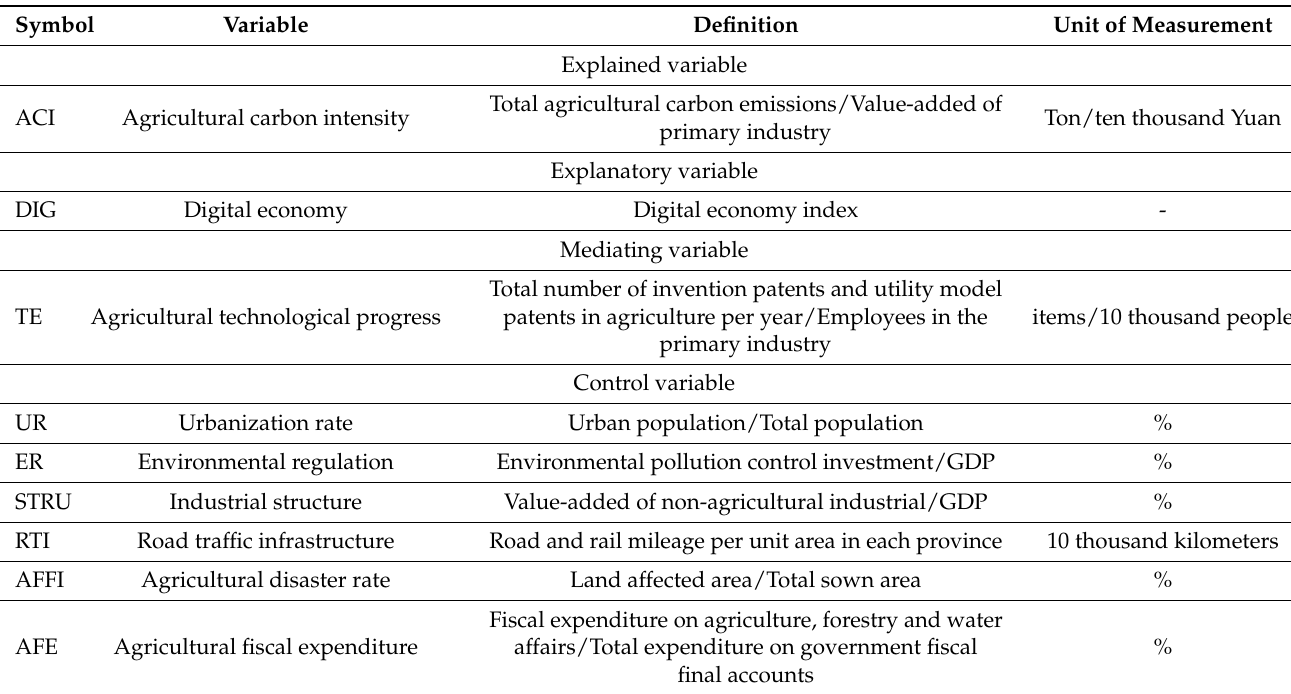
Table 3. Definition of all relevant variables used in the paper.